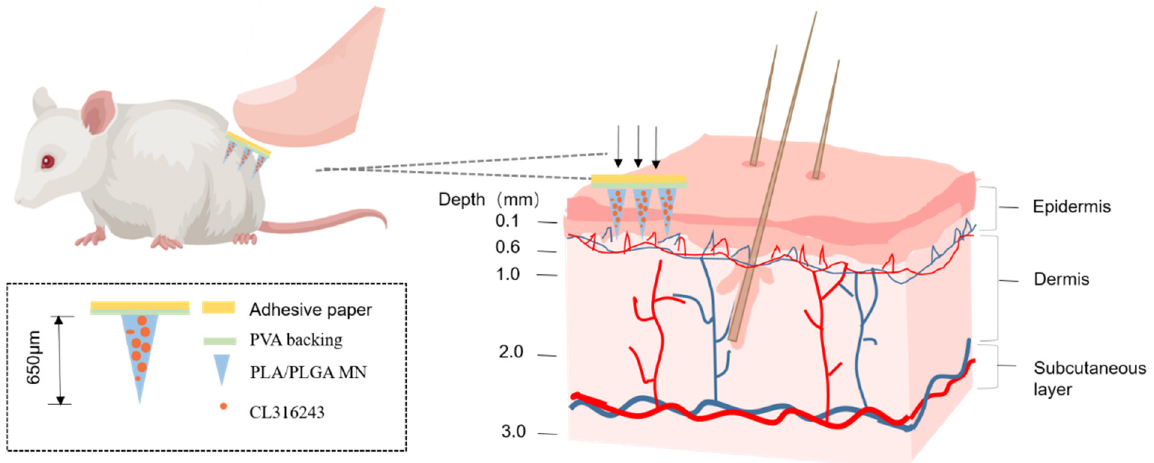
Figure 1. Schematic diagram of the concept. After applying the microneedle (MN) system to the groin on one side of the mouse, CL316243 was released from the MN and absorbed by the tissue capillaries. The dashed frame shows the composition of the microneedle materials.